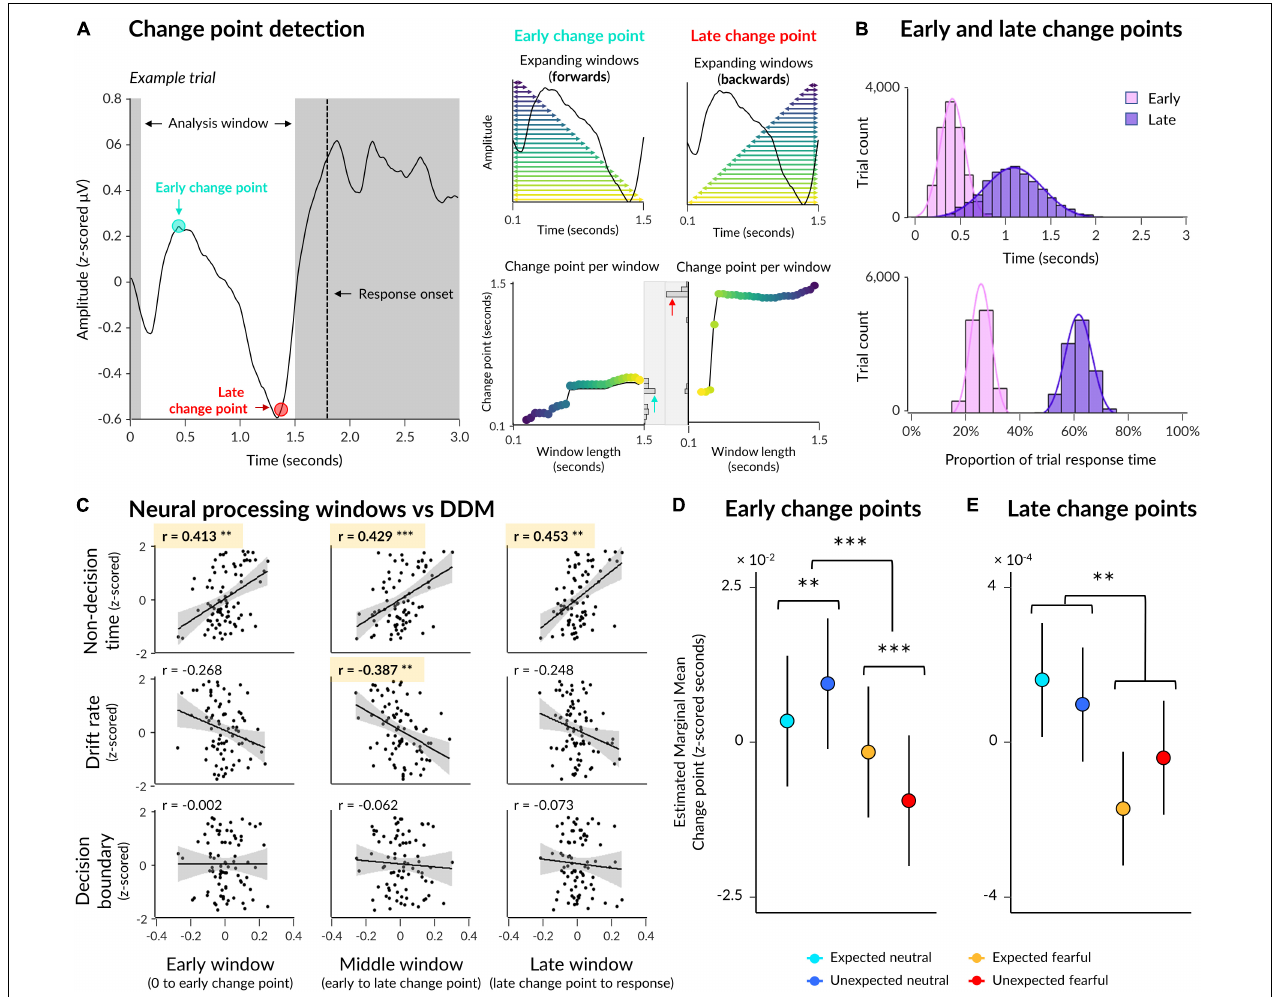
FIGURE 4 | Early and late change points in neural activity. (A) Illustration of the change point detection procedure with an exemplar ERP from a single trial (left). An analysis window was defined 0.1 s post-trial onset to 0.3 s pre-response onset. Early change points were computed by detecting abrupt changes in signal in multiple expanding windows where most windows contained earlier time samples (upper middle: each window is indicated by a horizontal arrow, with longer windows indicated by lighter colours), and then taking the most frequent change point across all windows (lower middle: change points indicated on y axis for each window length on the x axis, with a histogram of change points across all windows displayed on the right). Late change points were detected in the same way, except with windows expanding from the end of the analysis window to the start (upper right) so that most windows contained later time samples. (B) Early and late change points are pooled across all trials from all subjects, with change points displayed in seconds (top) as well as a proportion of each trial’s response time (bottom). (C) Correlations between drift diffusion parameters (rows) and neural processing windows (columns). (D) Estimated marginal means from a multilevel model where emotion and expectation predicted early change point time. Significant interaction and simple effects are indicated by asterisks. (E) Same as (D) except for late change points. Asterisks indicate a significant main effect of emotion. ∗ p < 0.05, ∗∗ p < 0.01, ∗∗∗ p <